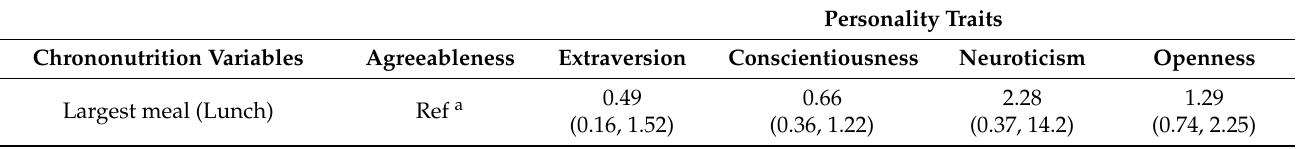
Table 4. Odds ratios (95% confidence intervals) for the association between binary chrononutrition outcomes and personality traits during the COVID-19 lockdown, assessed by logistic